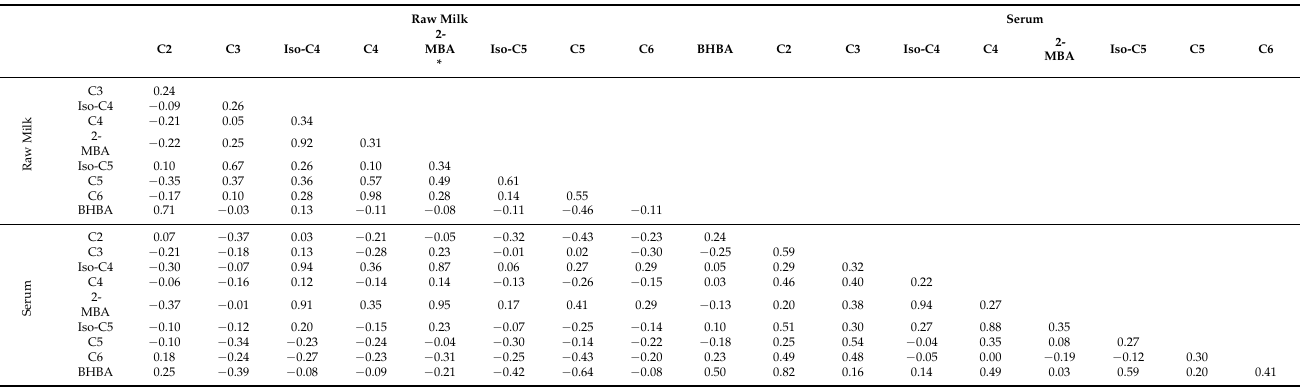
Table 5. Pairwise correlation among SCFA and BHBA in raw milk ( n = 19) and serum ( n =